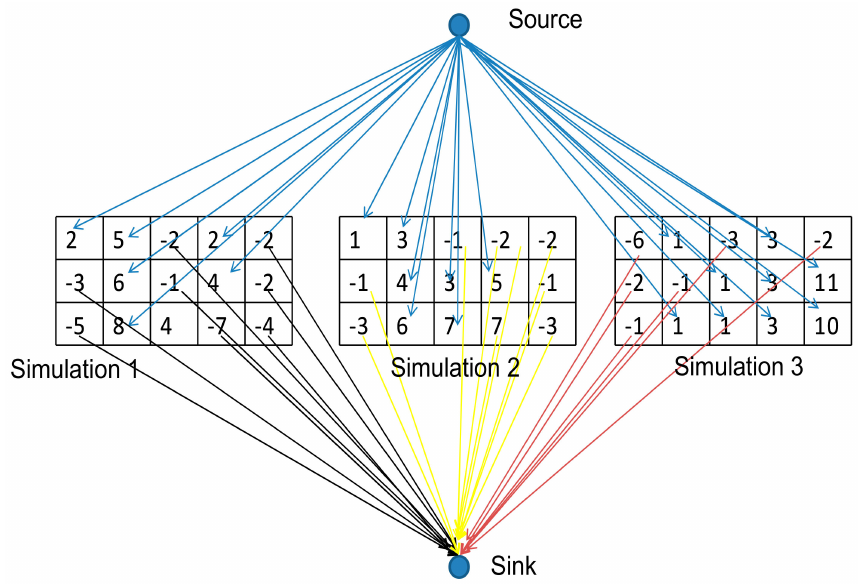
Figure 3. Multiple orebody models were used to create the